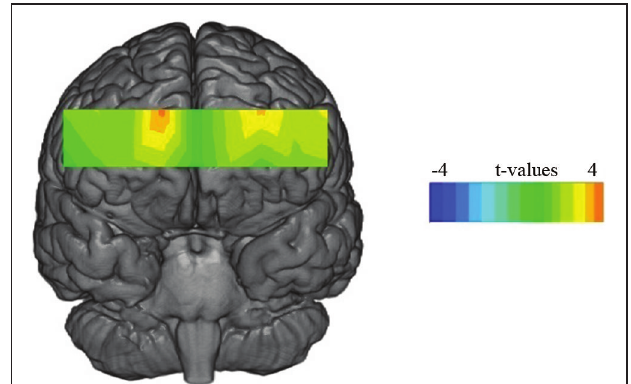
FIGURE 3 | Statistical maps showing t -values for oxygenated blood for the main effect of valence for the 60 s